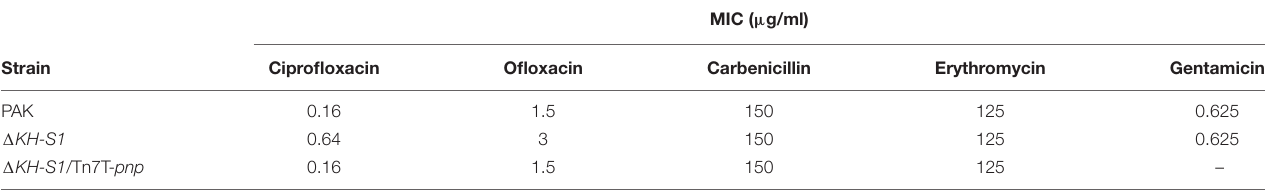
TABLE 2 | Bacterial susceptibilities to antibiotics.